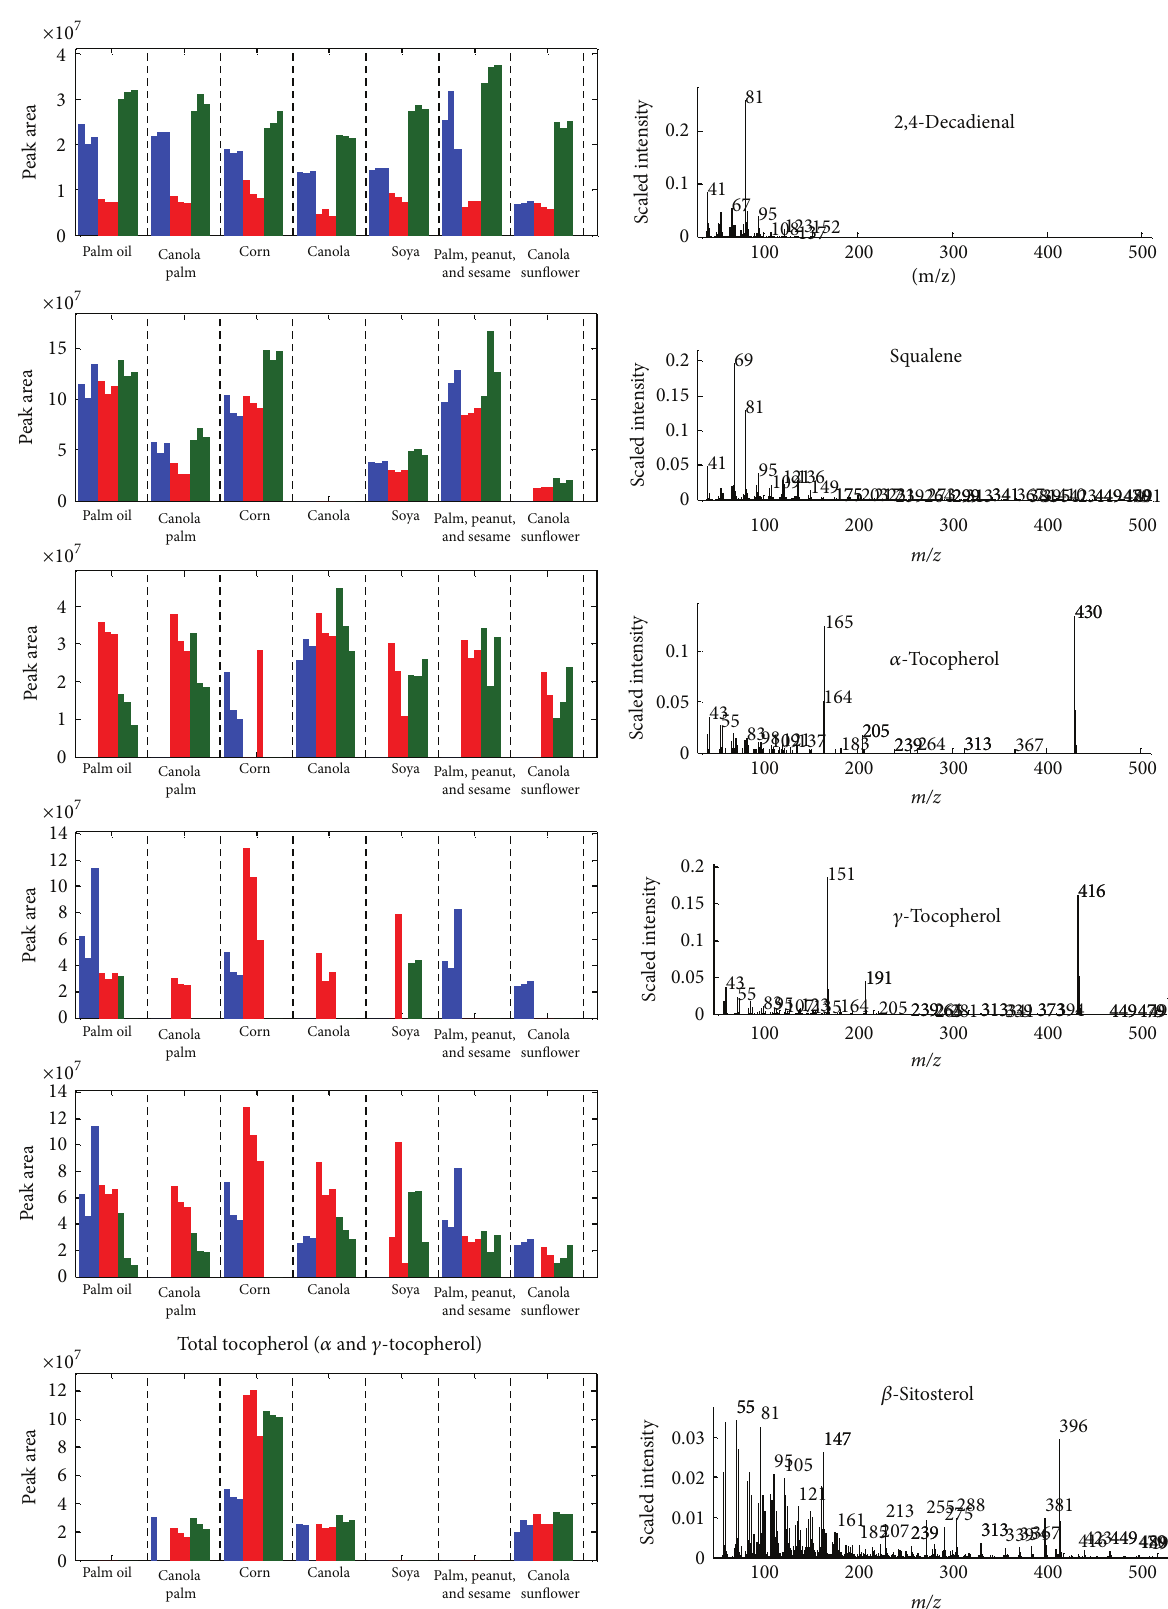
Figure 6: The relative abundance and mass spectra of several compounds identified in GCMS